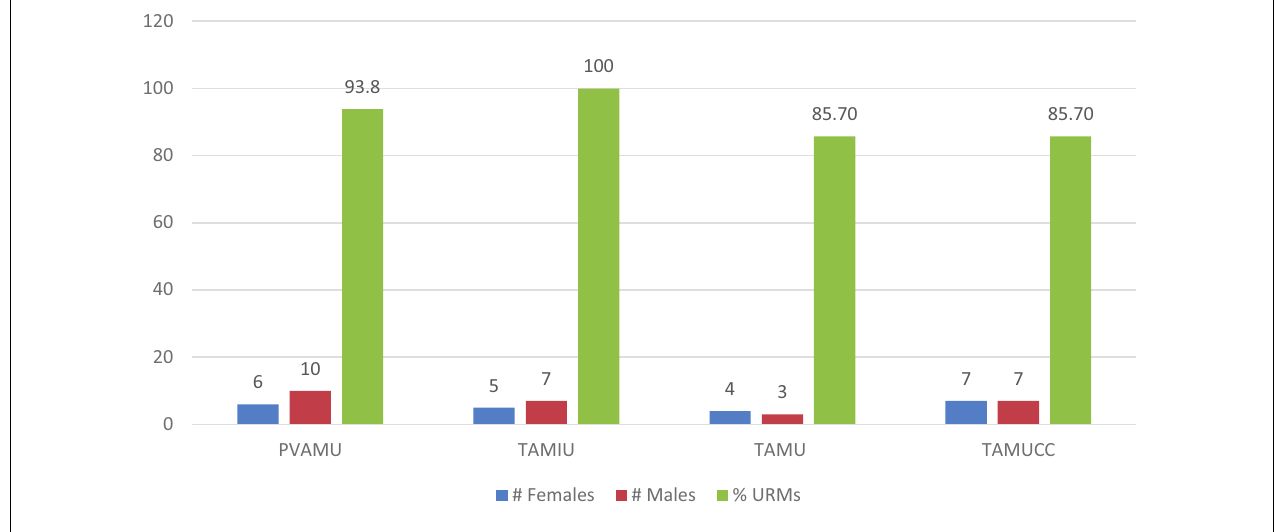
FIGURE 1 | Number of female and male students and percentage of underrepresented minorities (URMs) by campus for 2019 survey.